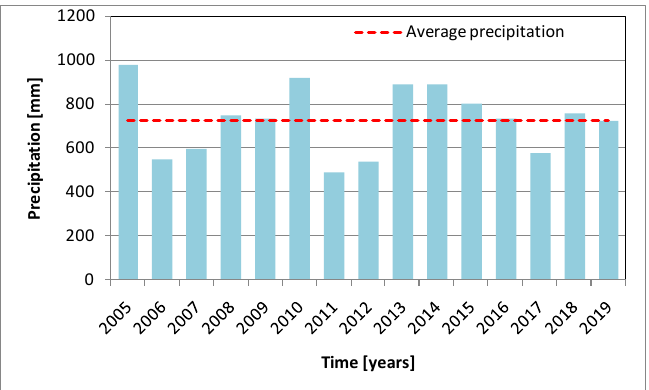
Figure 3. Histogram of the daily cumulative precipitation, and maximum (red) and minimum (light blue) daily air temperature values from 2005 to 2019.